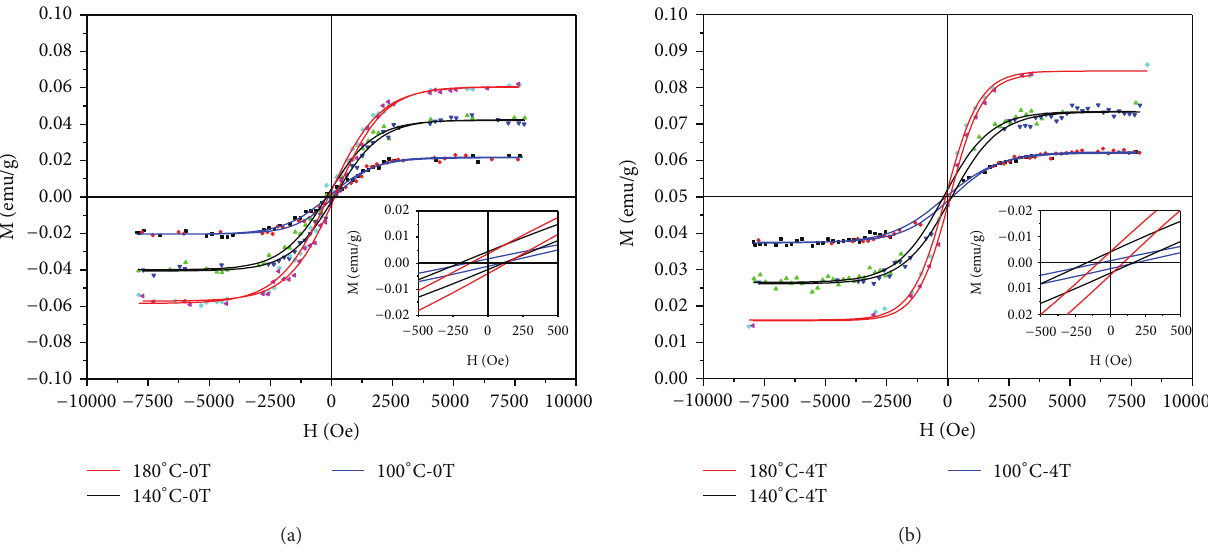
Figure 4: The magnetic hysteresis loops of the Cr-doped ZnO particles: (a) 0T and (b) 4T.